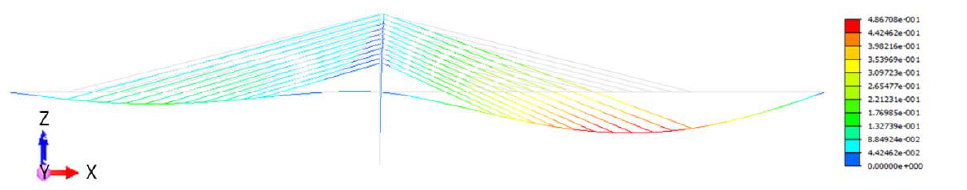
Figure 5. Deflection curves of the finite element